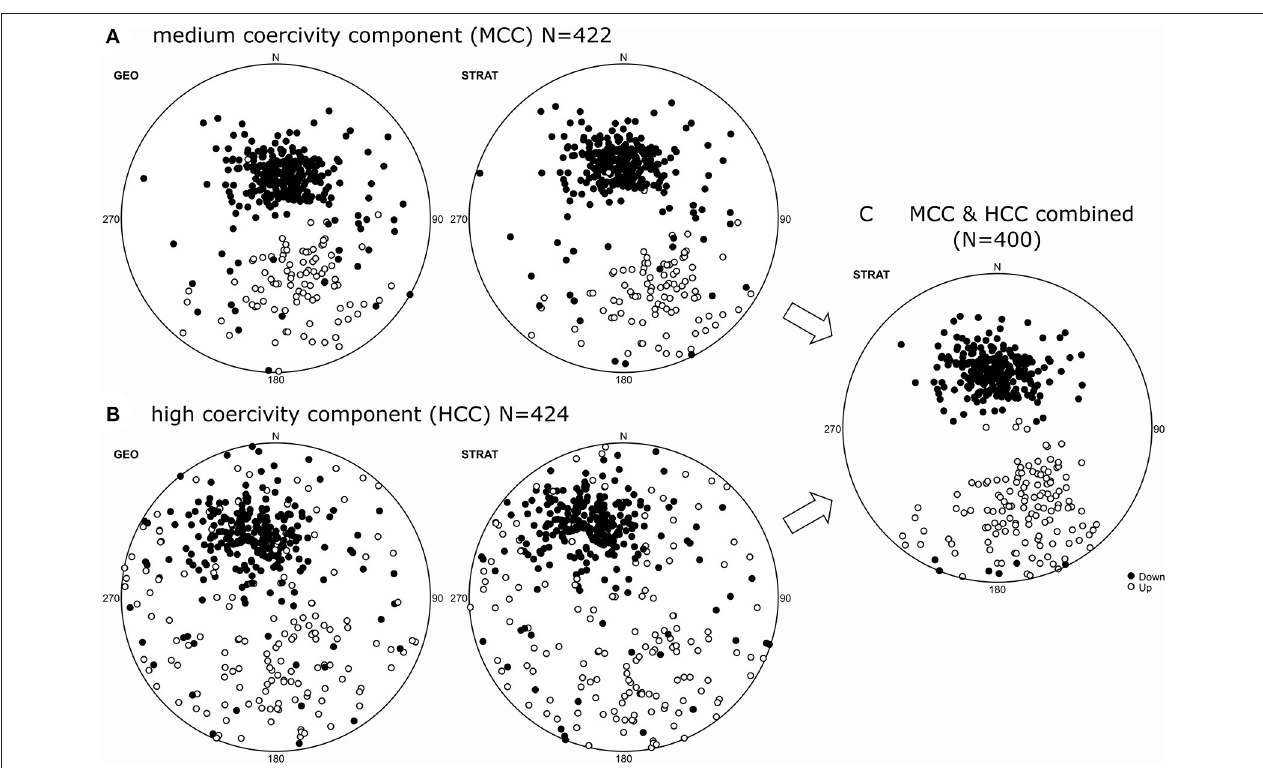
FIGURE 4 | Equal area projections of remanence directions determined from NRM demagnetization in geographic (left) and stratigraphic (middle) coordinates: (A) medium coercivity component (MCC) and (B) high coercivity component (HCC); (C) MCC & HCC combined data set in stratigraphic coordinates obtained from A and B (see text in section Characteristic Remanent Magnetizationfor